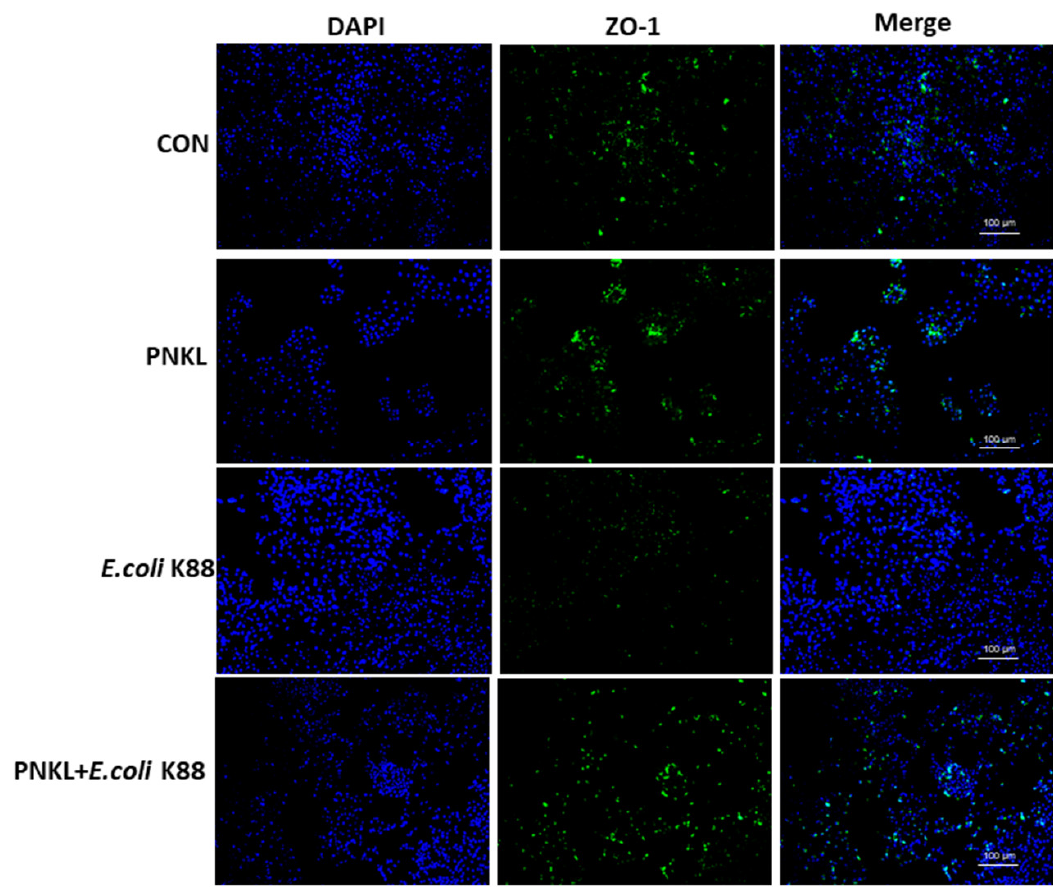
Figure 6. Effect of PNKL on distribution and abundance of ZO1 proteins. Representative immunofluorescent images for detection of ZO-1 (green) and DAPI (blue). Scale bar = 100 μm.